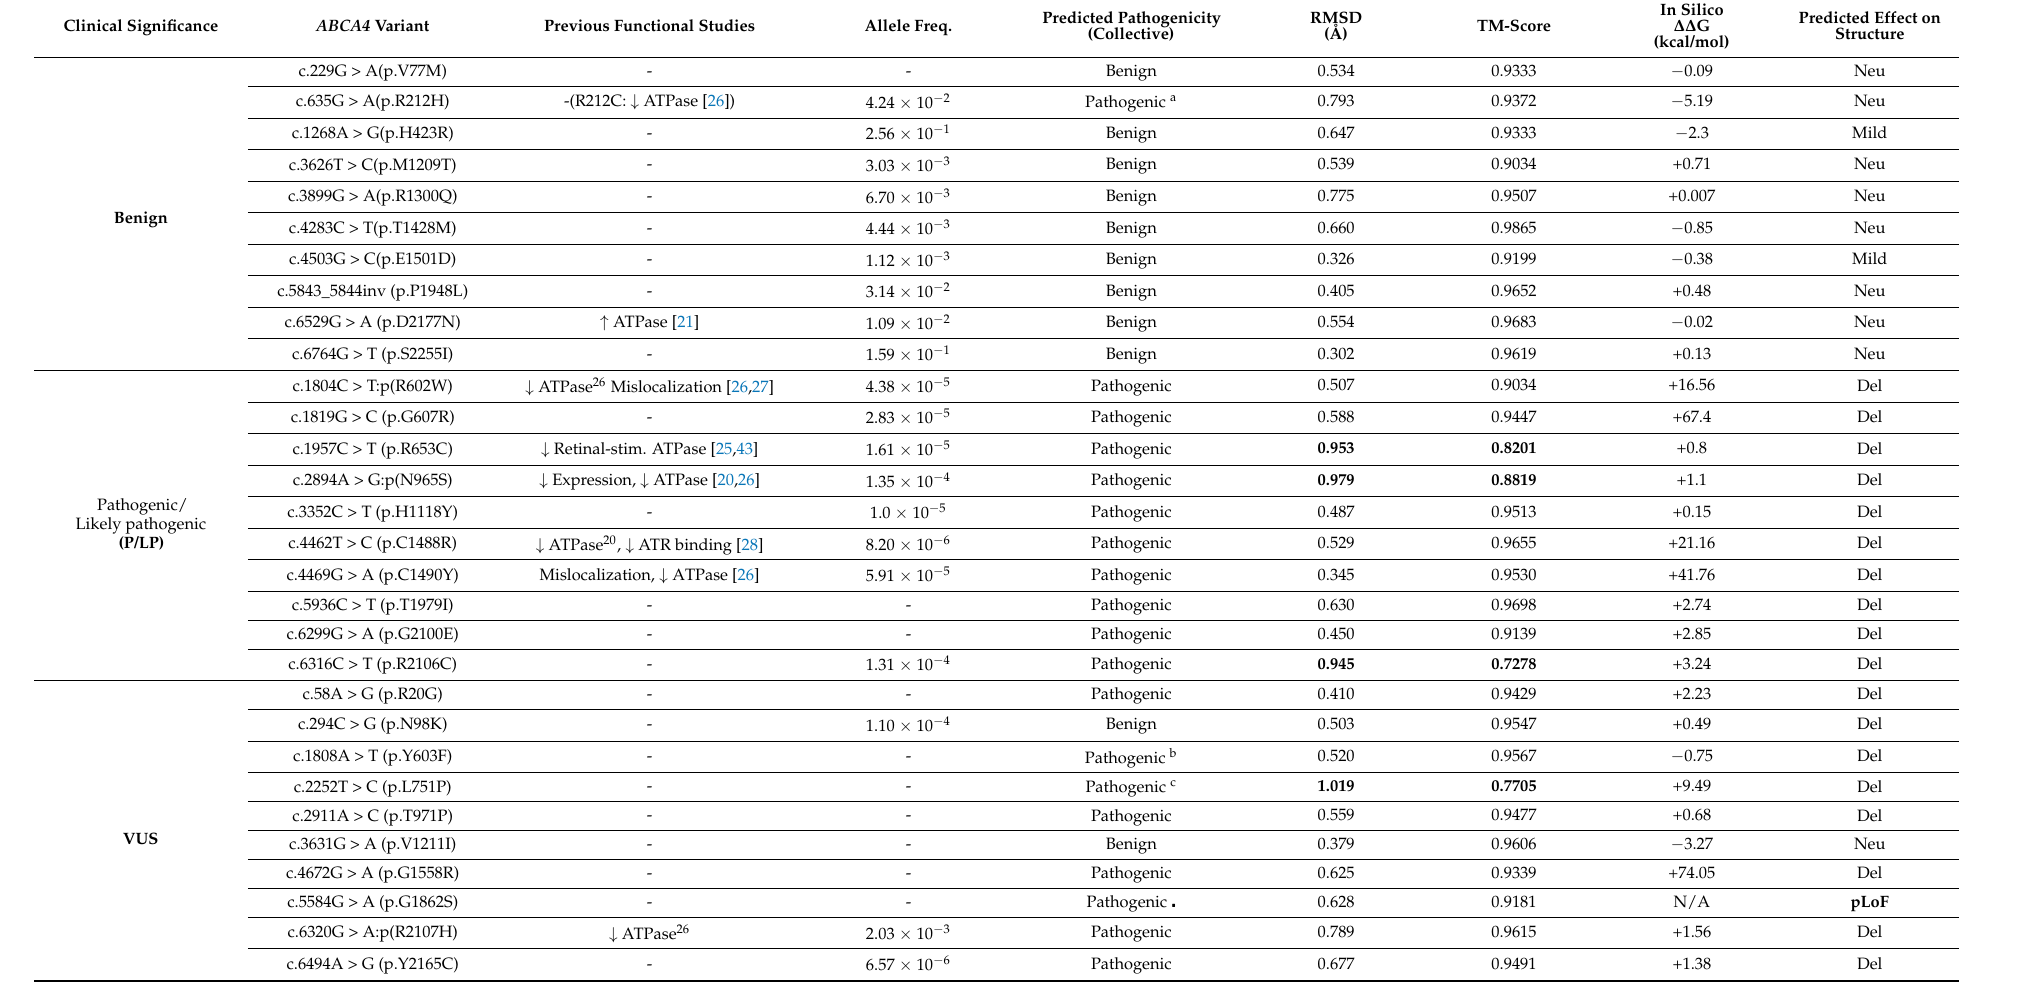
Table 1. ABCA4 missense variants with their corresponding pathogenicity and in silico structural analysis results. Clinical